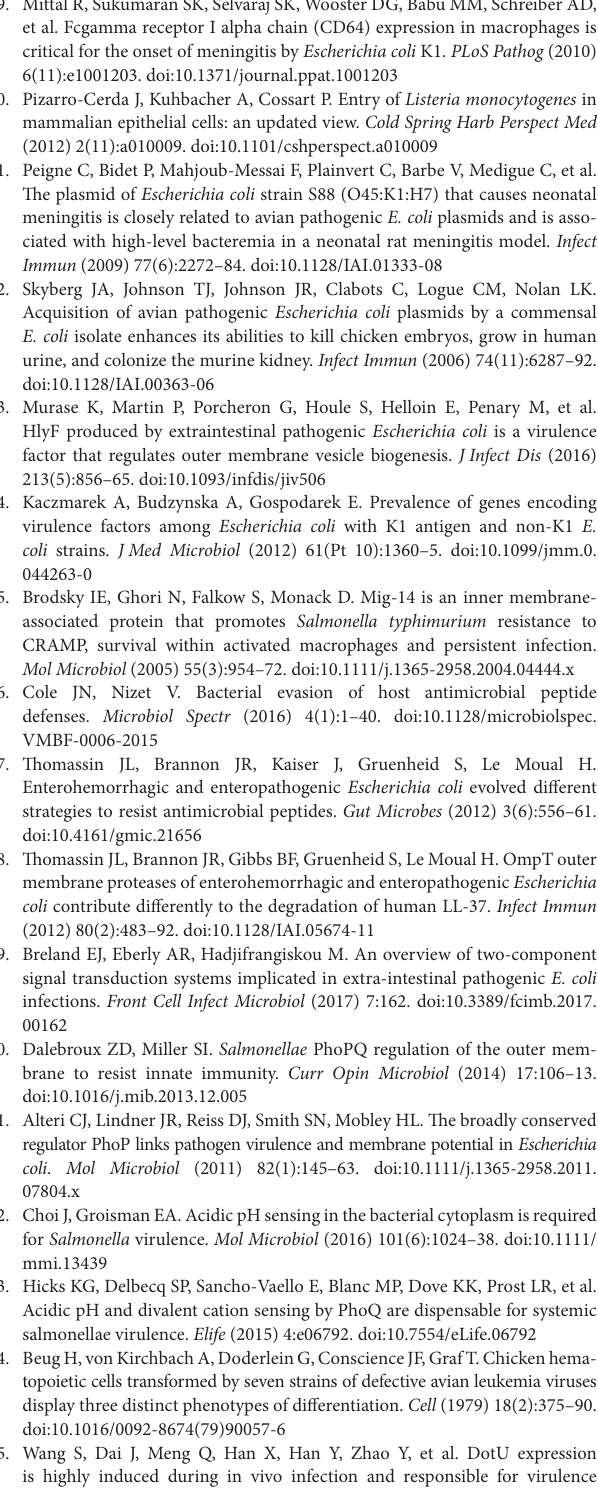
TaBle s1 | Bacterial strains and plasmids used in this study. TaBle s2 | Oligonucleotide sequences used as PCR primers in this study. TaBle s3 | MICs of antimicrobial peptides (AMPs) (LL-37 and